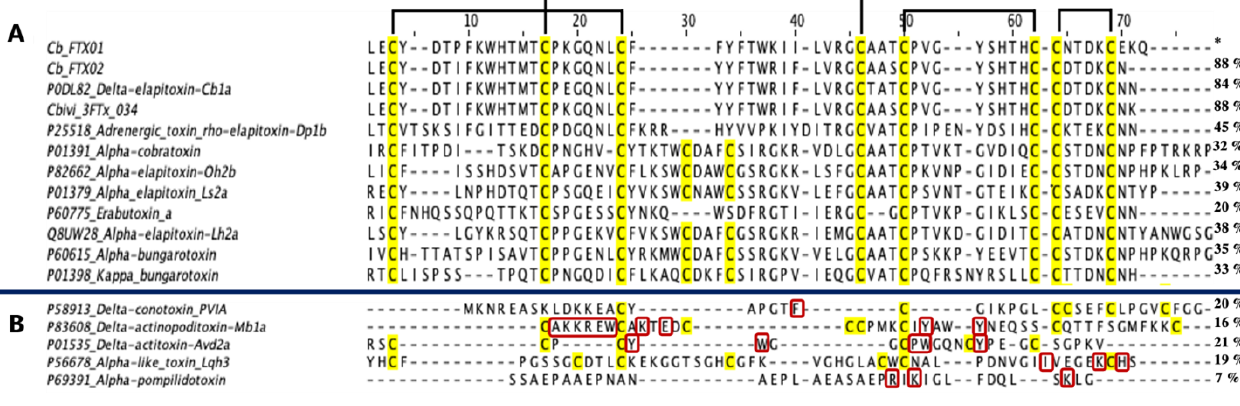
Figure 4. Multiple sequence alignments of Cb_FTX01 and Cb_FTX02 of Calliophis bivirgata flaviceps compared to functionally matched sequences from (A) serpentes and (B) non-serpentes groups obtained from public database. Percentage indicates the sequence similarities compared to Cb_FTX01(*). Black brackets: disulfide bridges, red regions: critical binding amino acid